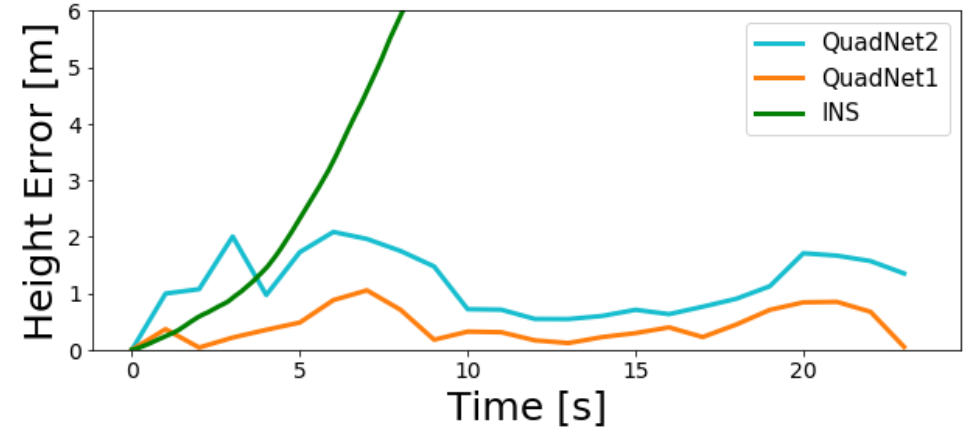
Figure 10. INS, QuadNet2, and QuadNet1 calculated height error throughout the trajectory for the first test dataset.